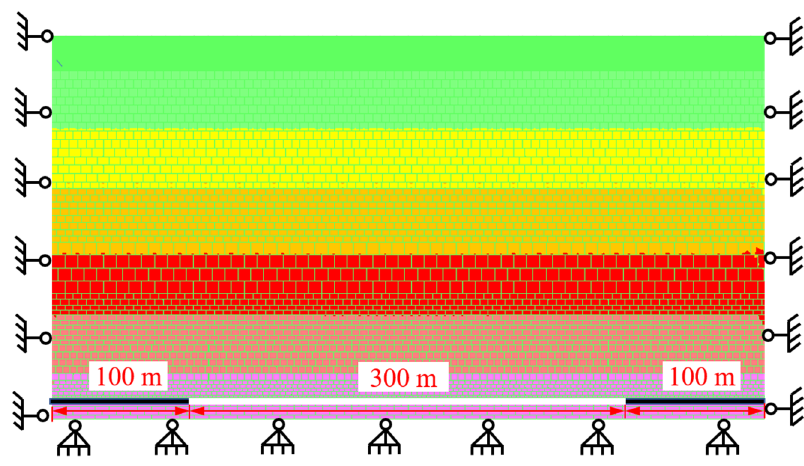
Figure 5. The numerical computation model.